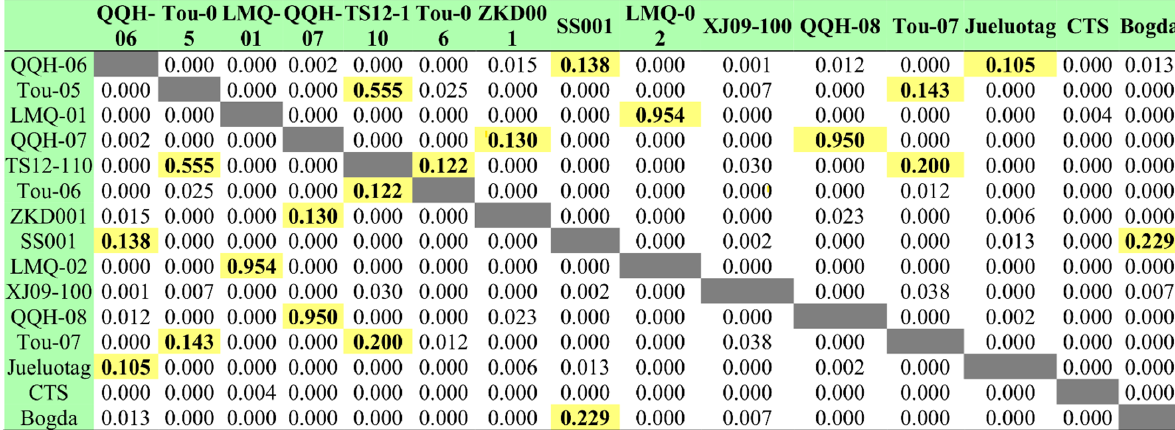
Figure 11. KS P-value tests for late Middle Jurassic–Late Jurassic samples (same derived data as those in Figures 8 and 10; 95% confidence that the two groups were not statistically different; p - values had to exceed 0.05; comparisons between units with p -values greater than 0.05 are high- lighted in